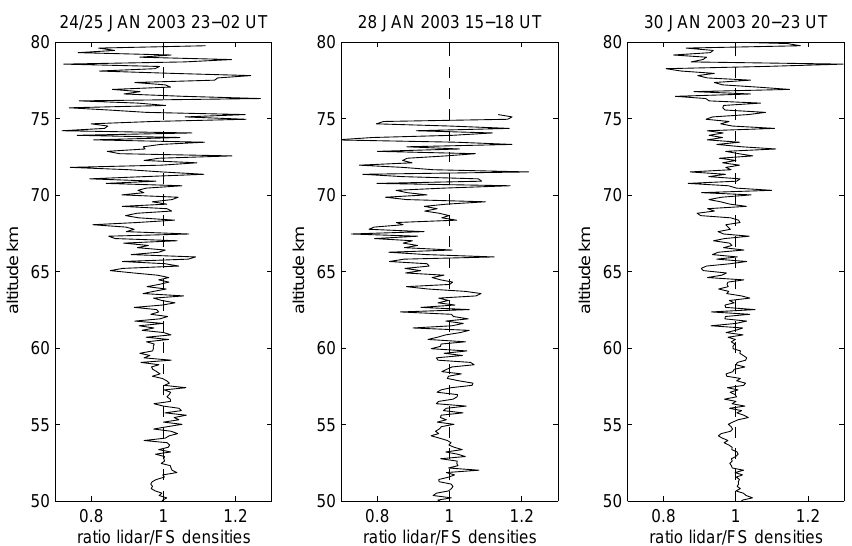
Fig. 5. Ratio of atmospheric backscatter from lidar and neutral number densities from falling sphere measurements on 3 occasions. In each case lidar measurements are integrated over 2–3h, and measurements from several falling spheres are averaged. The ratio is normalised so that the average over the height interval 50–60km is 1. For 24/25 January, lidar integration time is 23:31–01:27 UT, and spheres launched